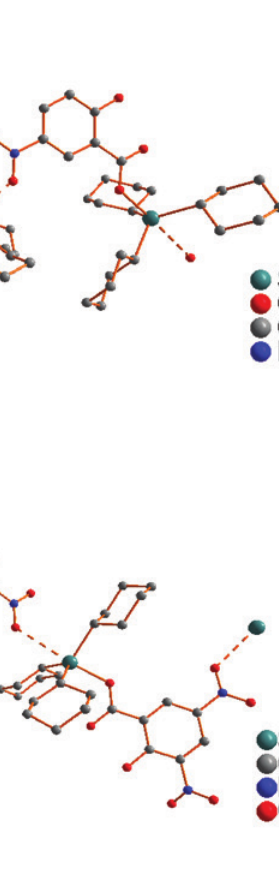
Figure 5: The zigzag chain of 3 formed by the intermolecular Sn···O interaction.